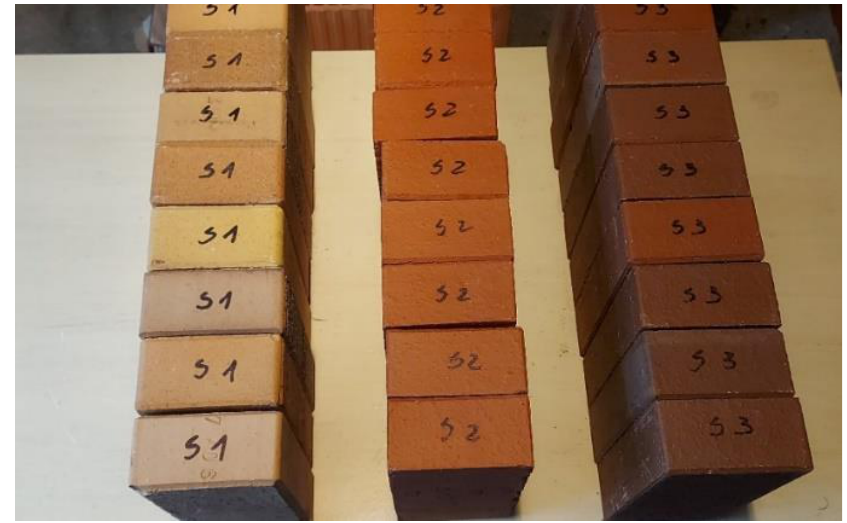
Figure 6. Specimens of clay paving blocks.